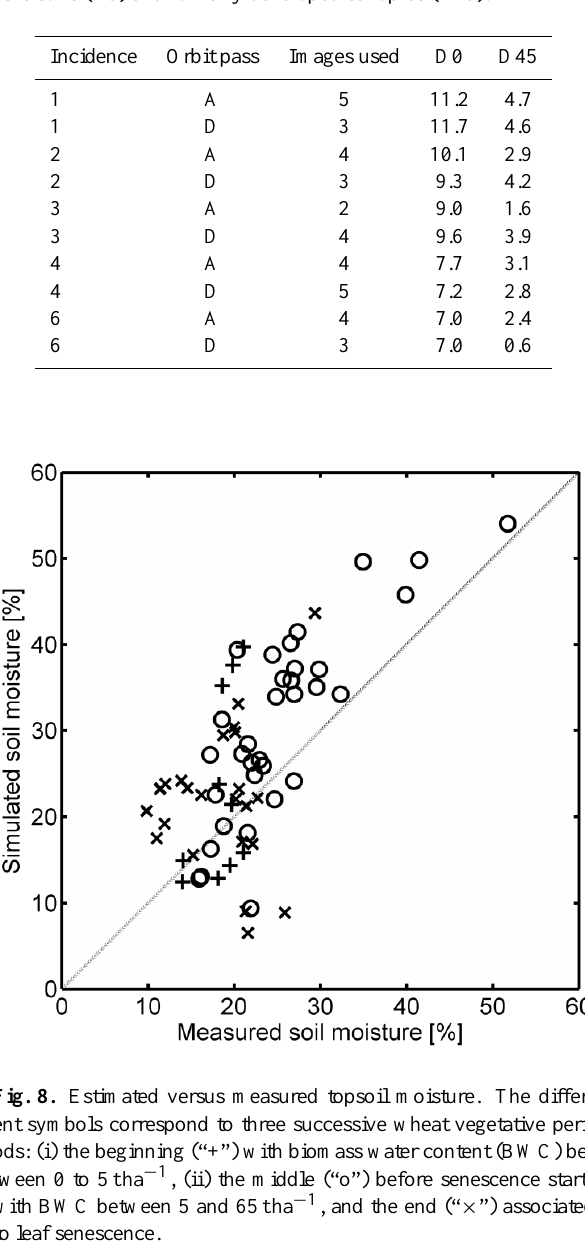
Table 2. Number of images available for each ASAR viewing con- figuration, and σ 0 HH distance between wet and dry conditions for bare soils (D0) and for fully developed canopies (D45).